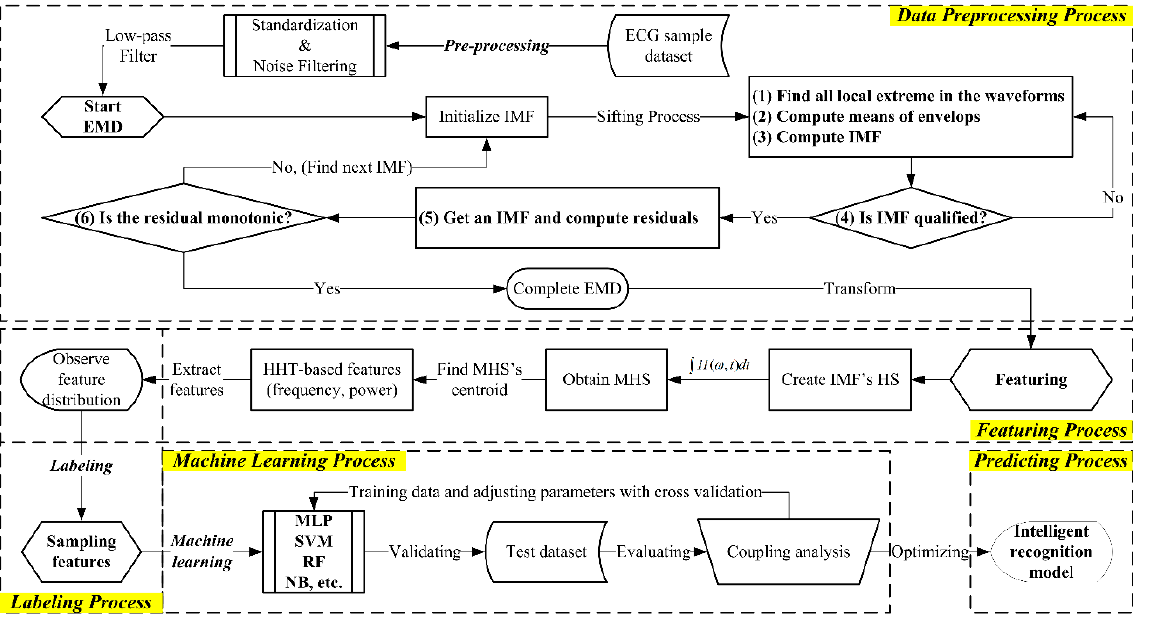
Figure 1. The AI-compliant modeling process with HHT-based featuring and coupling ML analysis for multiclass recognition of arrhythmia ECG